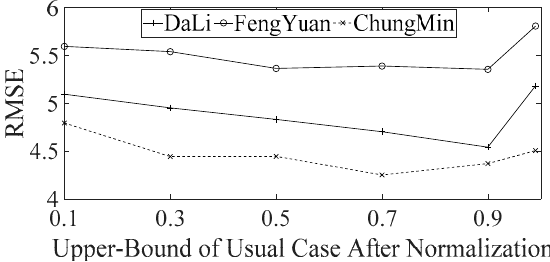
Figure 13. Influence of different upper bounds of normalized values for normal conditions on RMSE in usual case emphasizing normalization (UCENormalization).